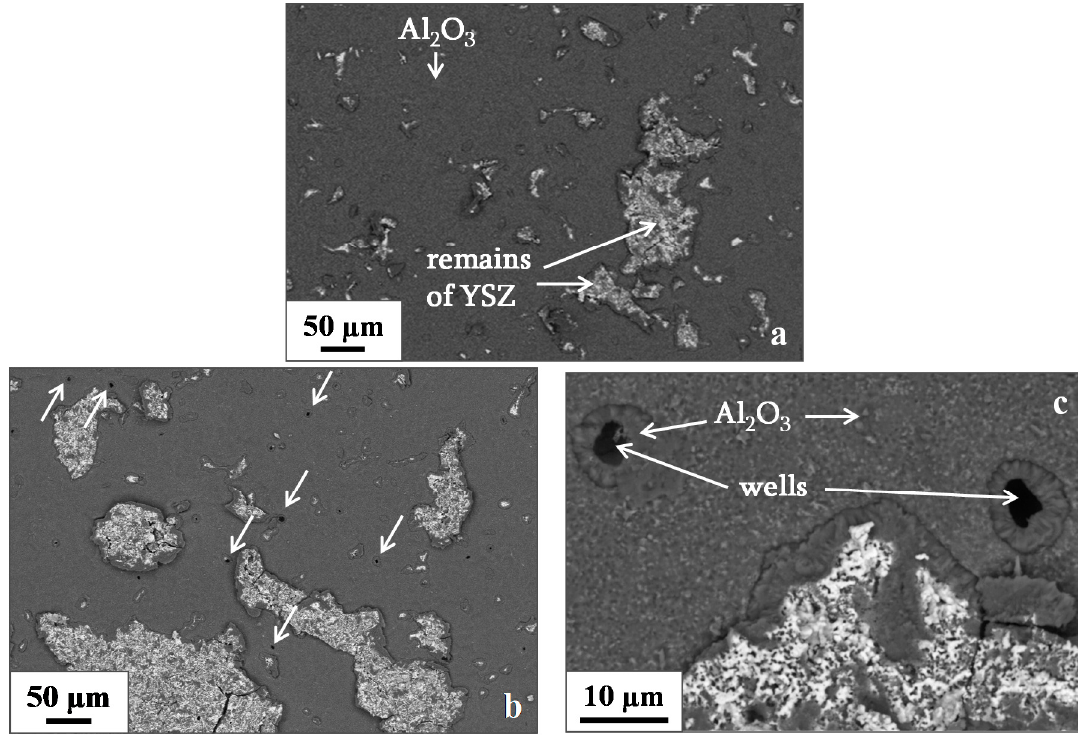
Figure 4. Bond-coating surface of ( a ) AM3-Trib-Pt/2 TBC system; ( b , c ) MCNG-Trib-Pt/2 TBC system after 300 cycles. The white arrows without a label identify the oxidized wells. Thermal cycles of 1 h at 1100 °C, with a high-flow air cooling. SEM images in BSE mode.